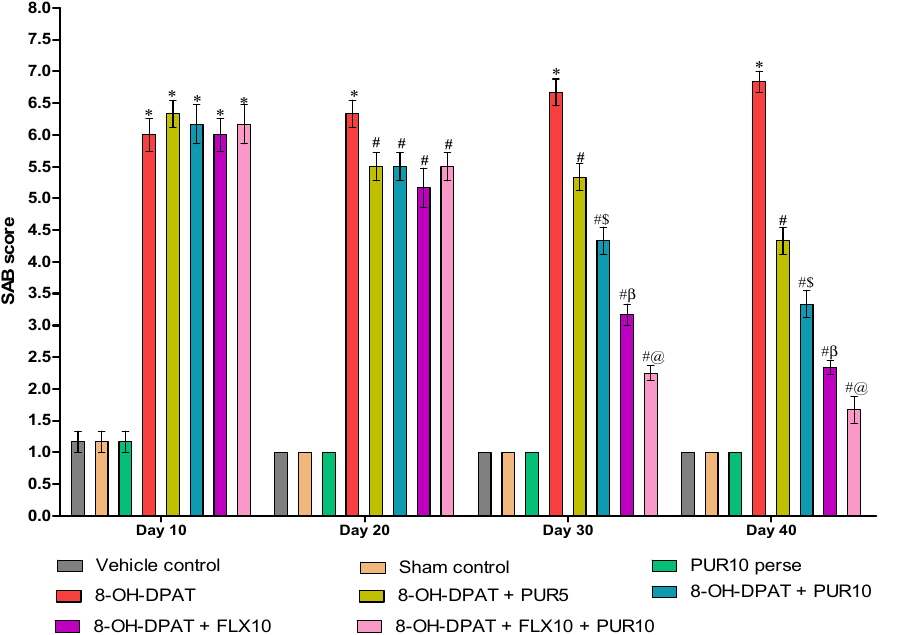
Figure 6. Effect of purmorphamine on spontaneous alternation behavior in 8-OH OCD. Statistical analysis followed by two-way ANOVA (post-hoc Bonferroni’s test). Values expressed as mean ± SEM ( n = 6 rats per group). * p < 0.01 v/s vehicle control, sham control and PUR10 per se; # p < 0.01 v/s 8-OH-DPAT; #$ p < 0.01 v/s 8-OH-DPAT + PUR5; # β p < 0.01 v/s 8-OH-DPAT + PUR5 and 8-OH-DPAT + PUR10; #@ p < 0.01 v/s 8-OH-DPAT + FLX10.